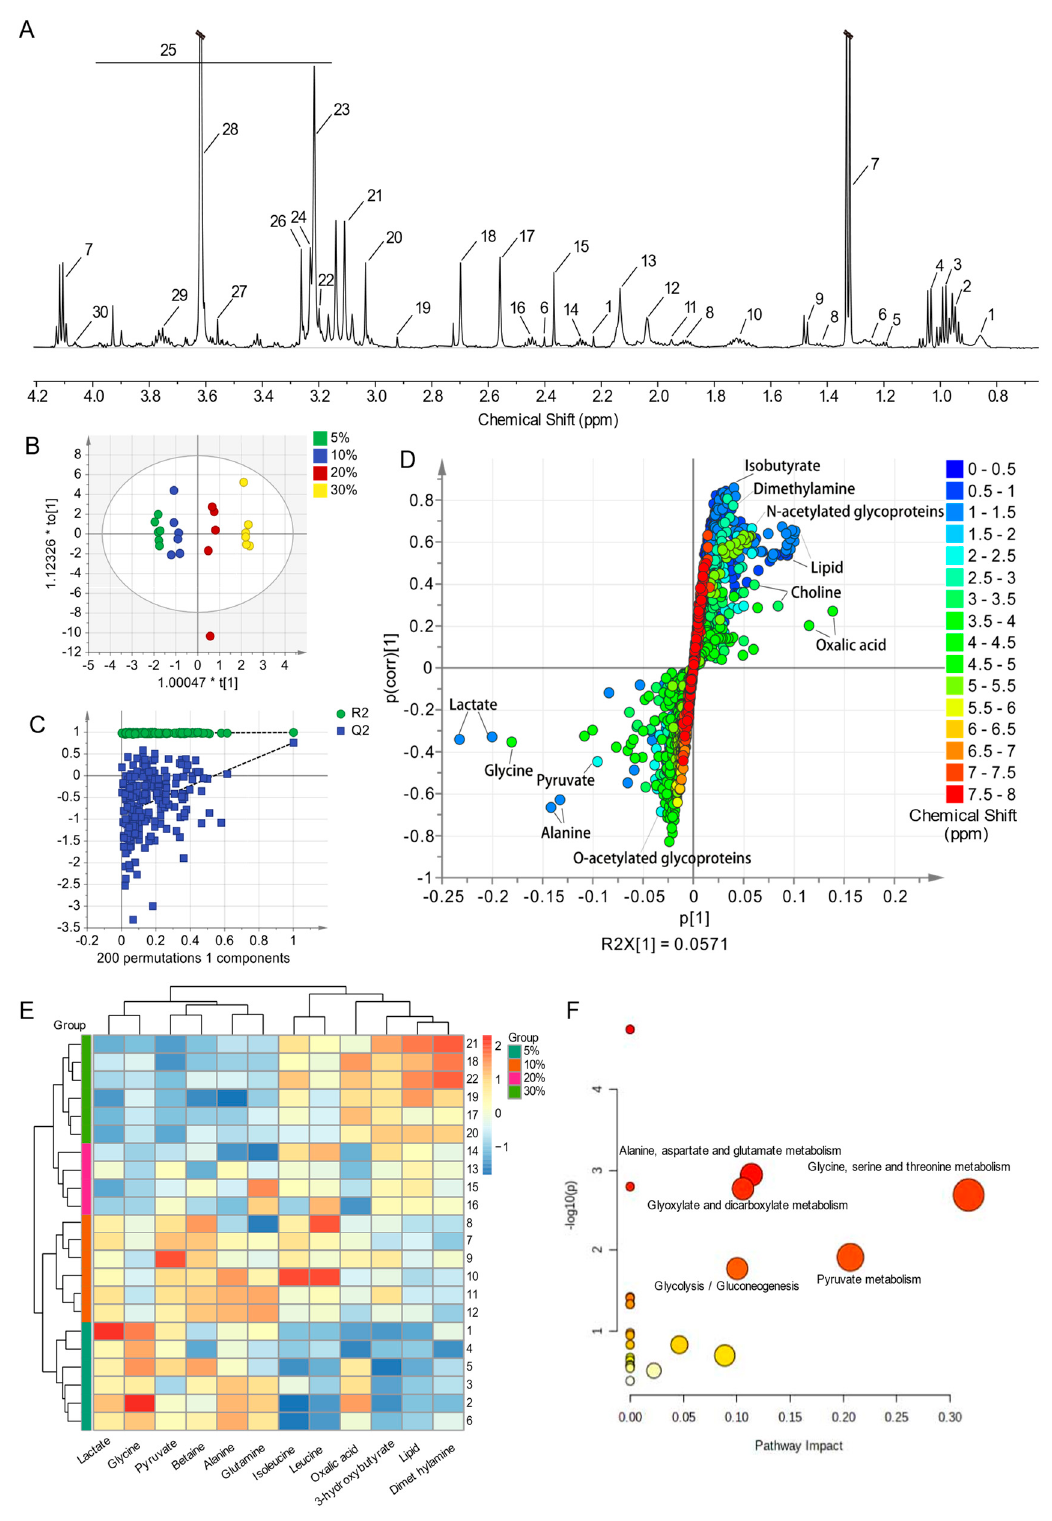
Figure 1. Different ratios of carbohydrate–fat have different effects on metabolic patterns. ( A ) Representative 600 MHz 1H NMR spectra of plasma (10% group). The 1H − NMR signals identified were: 1. lipid, 2. isoleucine, 3. leucine, 4. valine, 5. isobutyrate, 6. 3 − hydroxybutyrate, 7. lactate, 8. lysine, 9. alanine, 10. arginine, 11. acetate, 12. n − acetylated glycoproteins (NAG), 13. O − acetylated glycoproteins (OAG), 14. acetoacetate, 15. pyruvate, 16. glutamine, 17. succinate, 18. dimethylamine, 19. dimethylglycine, 20. creatinine, 21. phenylalanine, 22. choline, 23. trimethylamine N − oxide